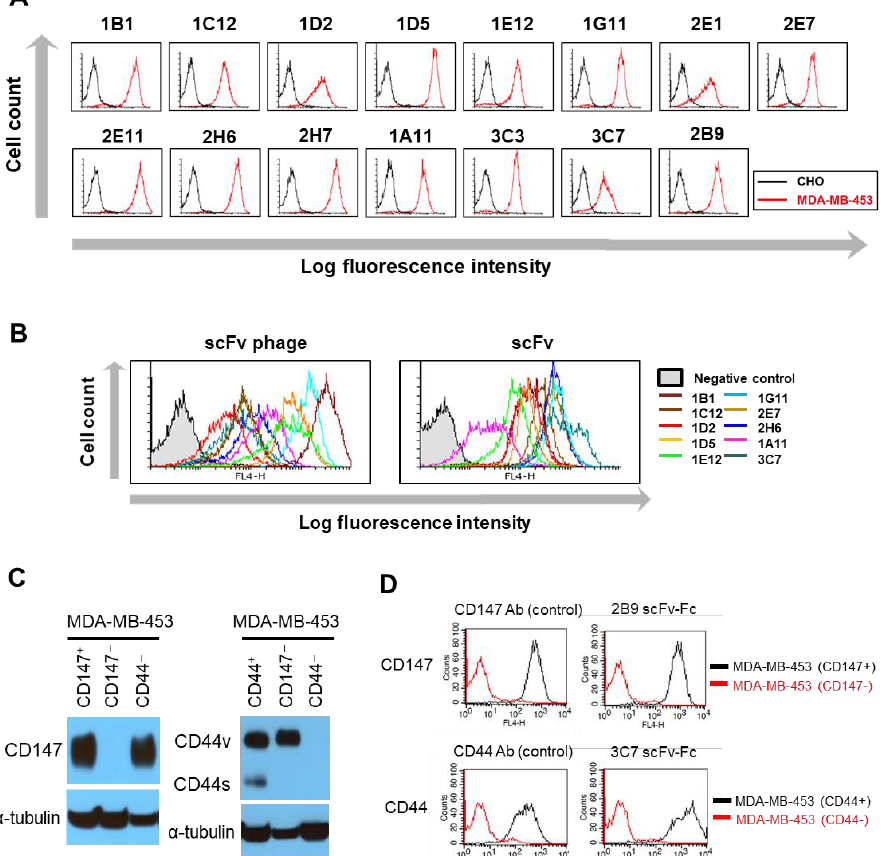
Figure 2. Binding assessment of selected antibodies against MDA-MB-453 by flow cytometry. ( A ) Binding of representative antibodies for cell-surface proteins on MDA-MB-453. CHO cells were used as negative control. ( B ) Representative histograms of scFv-phage and scFv antibodies binding to MDA-MB-453 with a diverse range of MFI. Normalized scFv-phage (1 × 10 9 cfu) and purified scFv (2.5 µ g / mL) was used for the analysis. The primary antibody was omitted in the negative controls. ( C , D ) Validation of the antibody specificity for CD147 and CD44 using cell lines that are antigen-negative cell lines. The protein gene for CD147 and CD44 targeted by 2B9 and 3C7 antibody, respectively, was knocked out by CRISPR / Cas9 gene-editing system. The target protein gene-knocked out clones were confirmed by flow cytometry and Western blot. ( C ) Analysis of CD147 and CD44 expression in CD147 − or CD44 − MDA-MB-453 cell lines by Western blot. Proteins from CD147 + (MDA-MB-453 / CD147 + / CD44 + ), CD147 − (MDA-MB-453 / CD147 − / CD44 + ), CD44 − (MDA-MB-453 / CD147 + / CD44 − ), and CD44 + (MDA-MB-453 / CD147 + / CD44 + ) cell lysates were resolved by SDS-PAGE under reducing conditions. CD147 and CD44 proteins were detected with 2B9 anti-CD147 and 3C7 anti-CD44 Ab, respectively, followed by HRP-conjugated secondary antibody. α -Tubulin was used as a loading control. The full images of Western blots are shown in Figure S3. ( D ) Shown are the histograms of cell staining for CD147 and CD44 in MDA-MB-453 (antigen-positive; black line) and antigen CD147 or CD44 knockout cell lines (antigen-negative; red line). Cells were stained with commercial anti-CD147 antibody (positive control Ab; GeneTex) and anti-CD44 antibody (positive control Ab; Cell Signaling Technology), in-house generated antibody 2B9 anti-CD147 or in-house generated antibody 3C7 anti-CD44 antibody, followed by Alexa Fluor ® 647 conjugated secondary antibody (Jackson